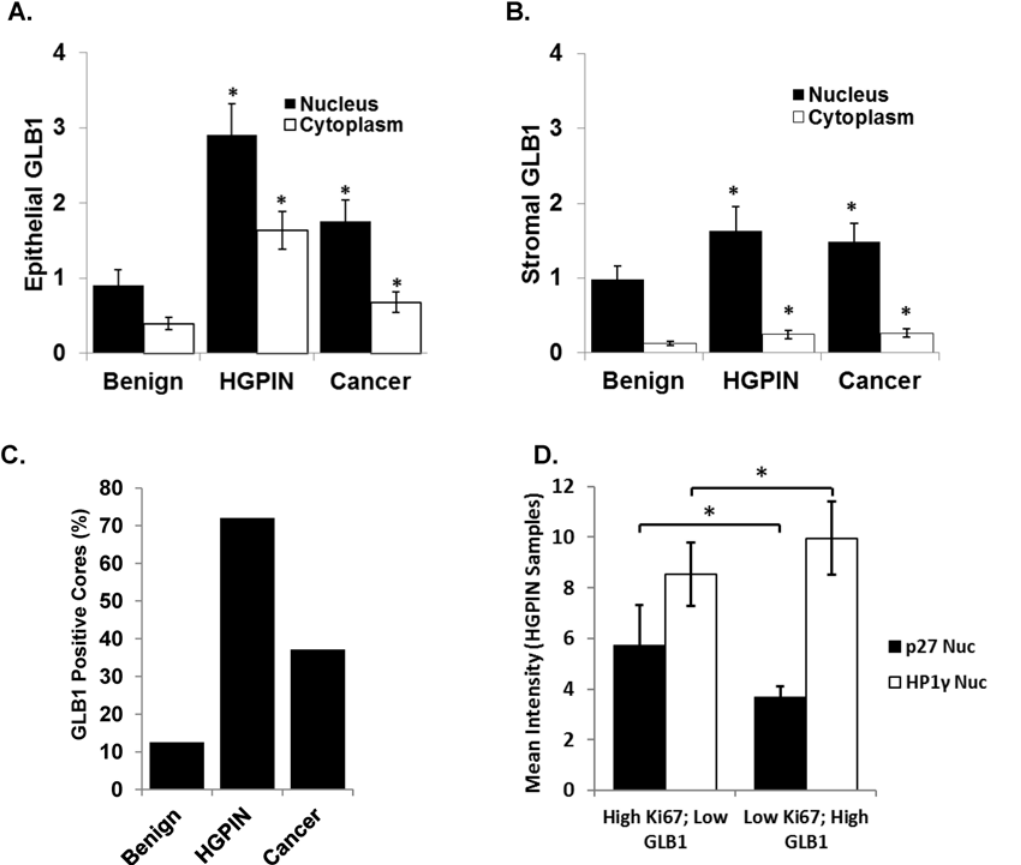
Fig 3. GLB1 increases expression in HGPIN and a subset of PCa and correlates with decreased proliferation and increased expression of HP1 γ . Gene expression was measured using the Vectra platform in a larger tissue array. In all tissue types, nuclei stained more strongly for GLB1 than the cytoplasm (p < 0.0001). Data are mean +/- 95% confidence intervals. * p < 0.001. (A) Epithelial GLB1 expression is significantly increased in HGPIN and cancer compared to benign prostate in both nuclear and cytoplasmic compartments (All p < 0.0001). (B) Stromal GLB1 expression levels in HGPIN and cancer exhibited similar intensities of staining (p < 0.001 all). (C) The mean GLB1 expression was calculated for all samples and the number of cores that overexpressed GLB1 was determined for each pathologic entity. Primary cancer samples demonstrated increased expression in a subset of samples (nuclear expression shown). (D) The microarrays were immunostained for the proliferation protein Ki67, the heterochromatin protein HP1 γ increased in senescence, and p27, a marker decreased in terminal senescence. Separating HGPIN cores into high and low Ki67 and GLB1 staining, the population of high GLB1-low Ki67 (right), representing the senescent population, expressed low p27 and high HP1 γ as expected for senescent cells. This was significantly different from the expression of p27 and HP1 γ in the low-GLB1-high Ki67 population (left), confirming the association of GLB1 with other senescent markers in vivo . Other subpopulations (high GLB1-high Ki67 and low GLB1-low Ki67) did not demonstrate significance and were omitted for